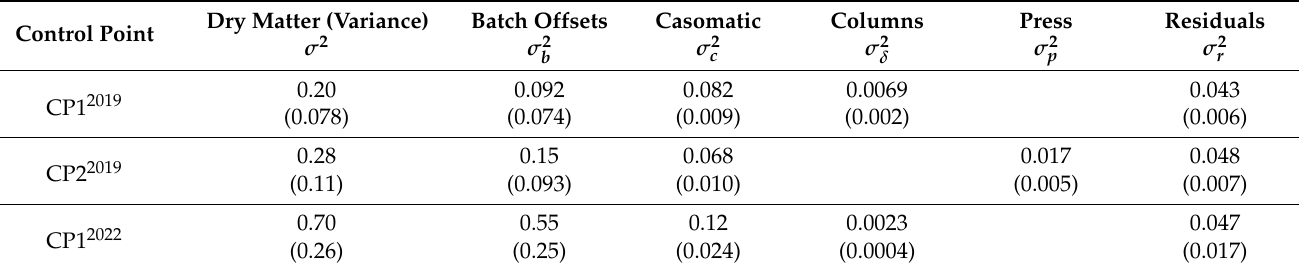
Table 1. Average (standard deviation) over sequences of variance of the dry matter signal and of its different components. An estimate of the “columns” contribution at CP2 is left out as the PSD suggested that this component is dominated by the noise level.